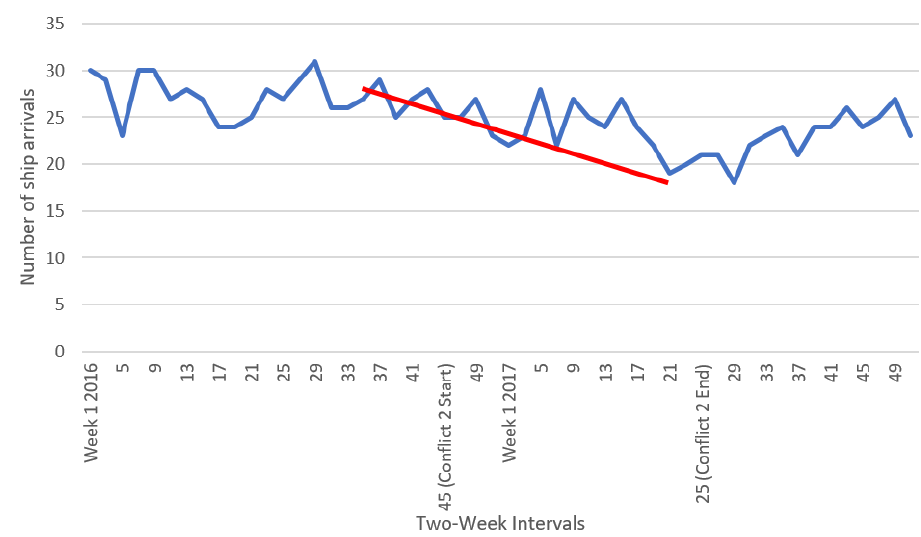
Figure 4. Number of Ship Arrivals at the Port of Gothenburg in Two-Week Intervals (2016–2017).